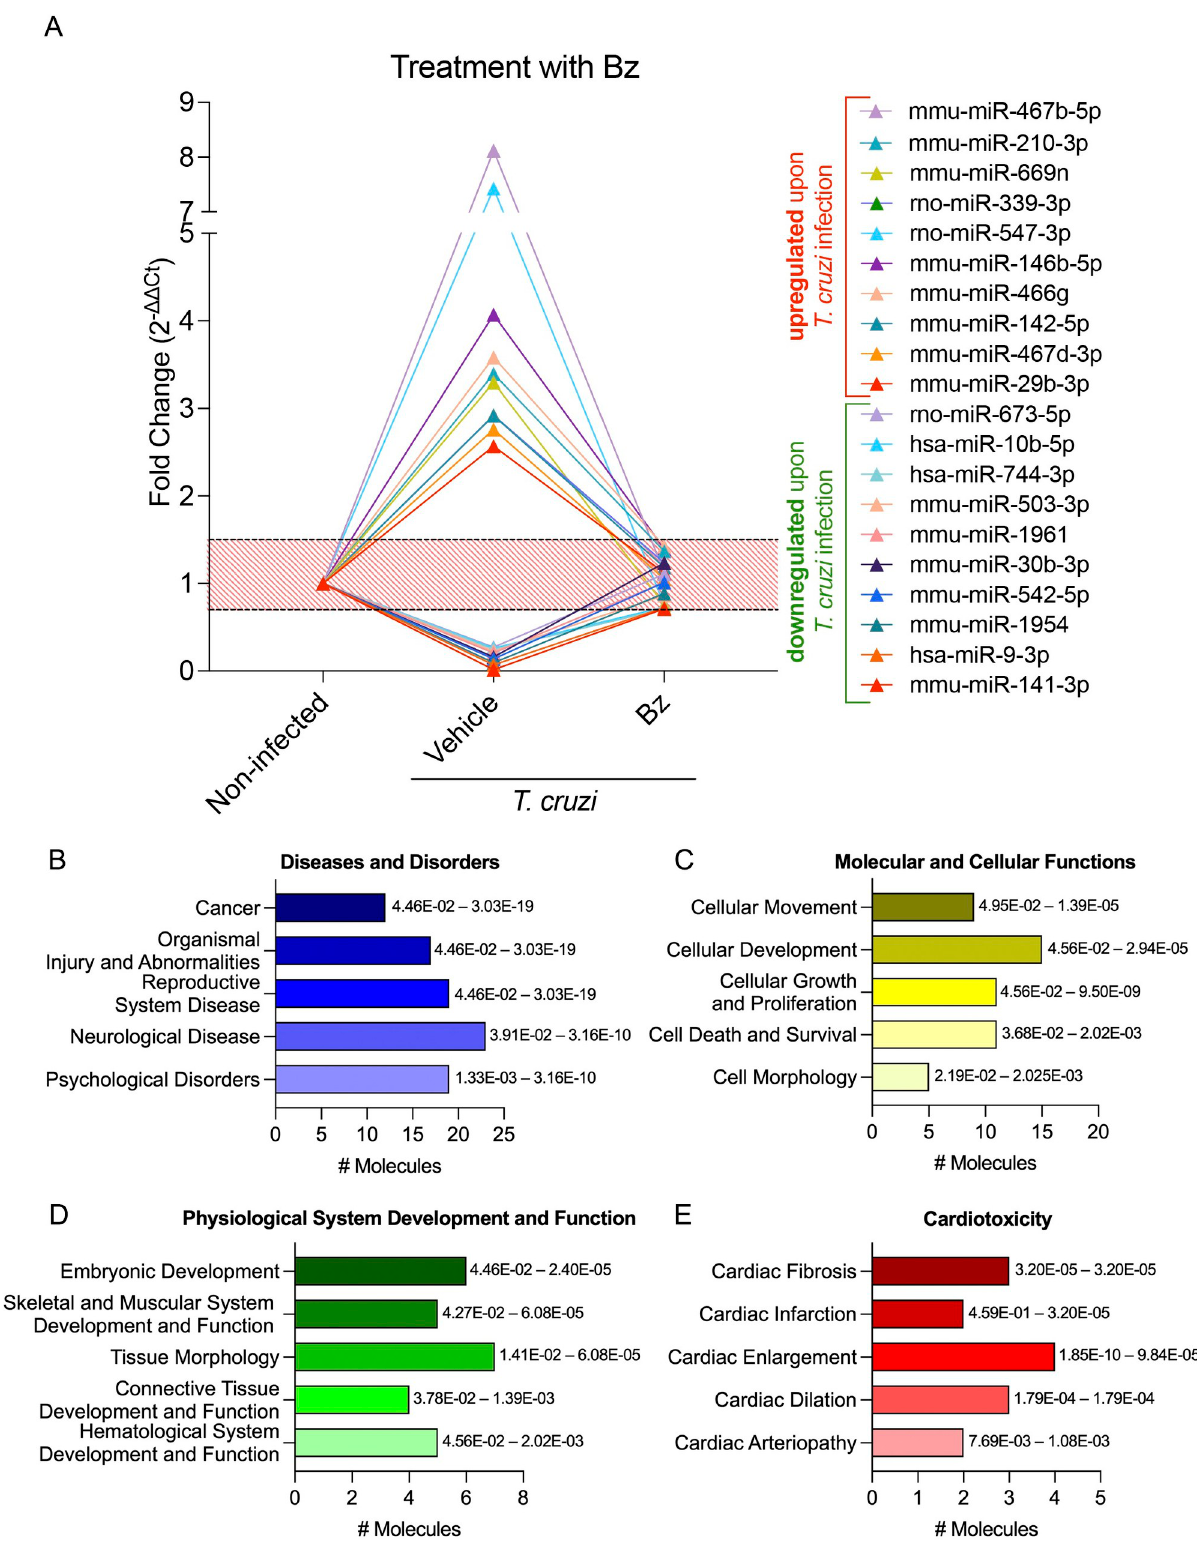
Fig 5. Characterization of immune response expression profile for the Bz group. (A) Expression of miRNAs altered in the infected group and with a restored expression upon Bz therapy. Relative expression was expressed as fold change (2 - ΔΔ Ct ). miRNAs with a fold change greater than 1.5 in